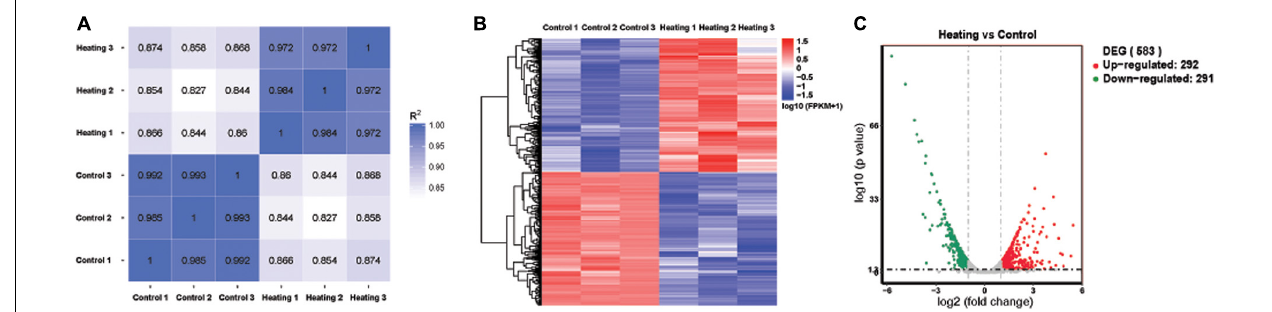
FIGURE 2 | Differentially expressed genes (DEGs) by RNA-seq. (A) Pearson’s correlation heatmap of expression of all mapped genes (B) Hierarchical clustered heat map of significantly differentially expressed genes (583). (C) Volcano plot displaying DEGs. The vertical axis corresponds to the q -value, the horizontal axis displays the log 2 fold-change. The red dots represent the up-regulated expressed transcripts (292), the green dots represent the down-regulated transcripts (291). Vertical and horizontal dashed lines indicate absolute log 2 fold-change = 1 and adjusted p = 0.05, respectively.